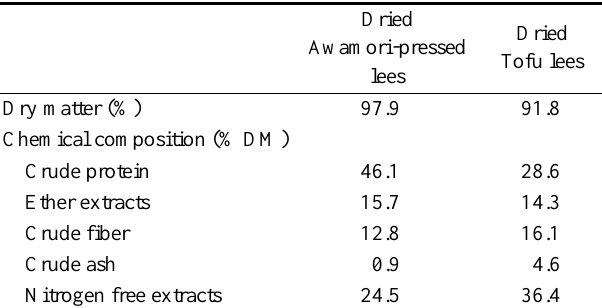
Table 3. Ingredients of Control feed (CF), Awamori-pressed lees mixed feed (AMF) and Tofu lees mixed feed (TMF)